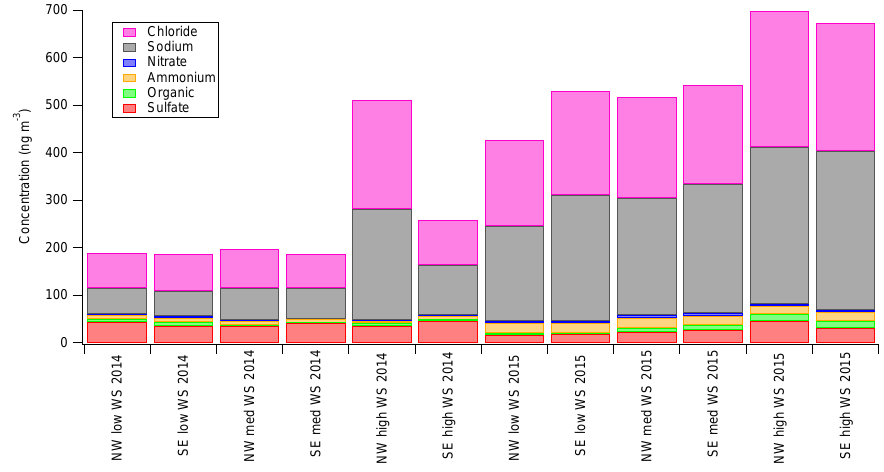
Figure 7. Aerosol-phase concentrations of AMS species as a function of low-wind-speed (0–1.99ms − 1 ), medium-wind-speed (2– 7.99ms − 1 ), and high-wind-speed (8 + ms − 1 ) regimes for NW (marine) and SE (continental) wind directions. Error bars are omitted for readability but are ± 10 for Chl, ± 10 for Na, ± 1 for Org, ± 3 for SO 4 , ± 1 for NO 3 , and ± 2 for NH 4 for the 2014 spring–summer measure- ments and ± 35 for Chl, ± 35 for Na, ± 2 for Org, ± 5 for SO 4 , ± 2 for NO 3 , and ± 3 for NH 4 for the 2015 winter–spring measurements.